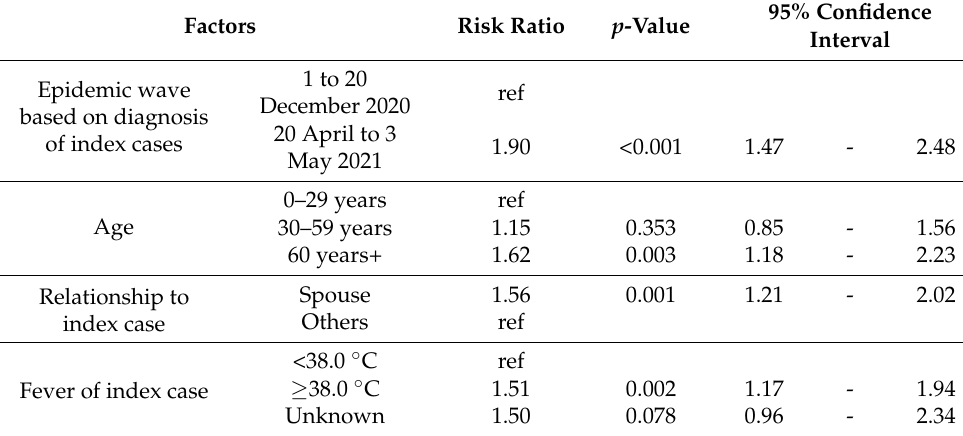
Table 2. Factors associated with the secondary attack rate of SARS-CoV-2 for Japanese household contacts focusing on the epidemic wave using multivariable Poisson regression analysis.